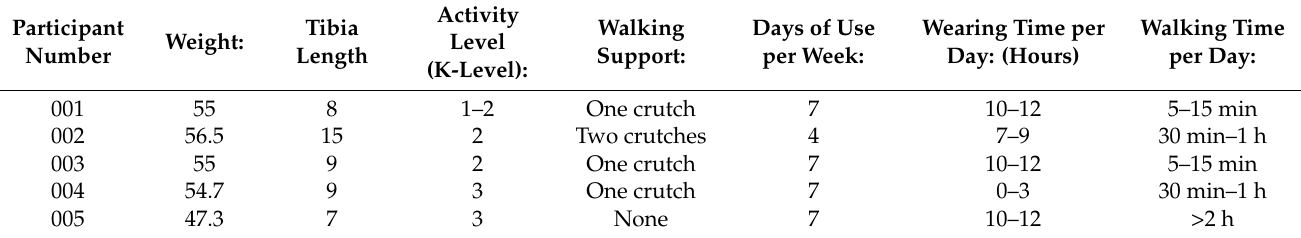
Table 3. Participant characteristics, including the amount of time using the prosthesis.